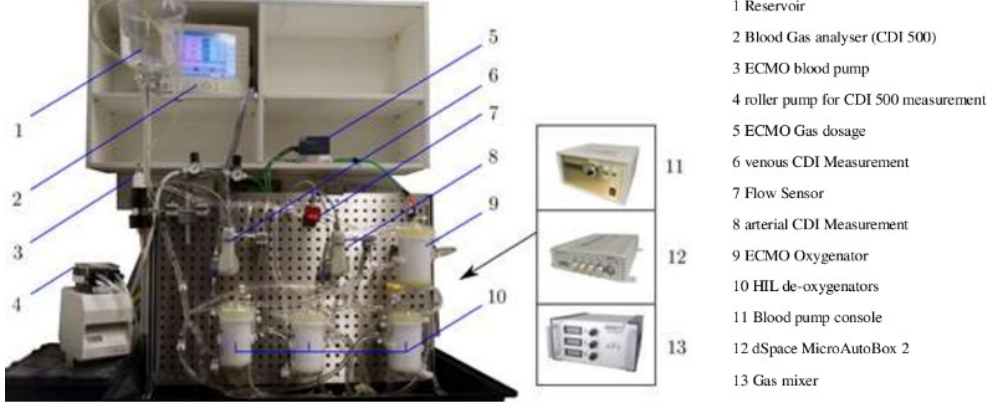
Figure 17. Artificial lungs simulator [29].